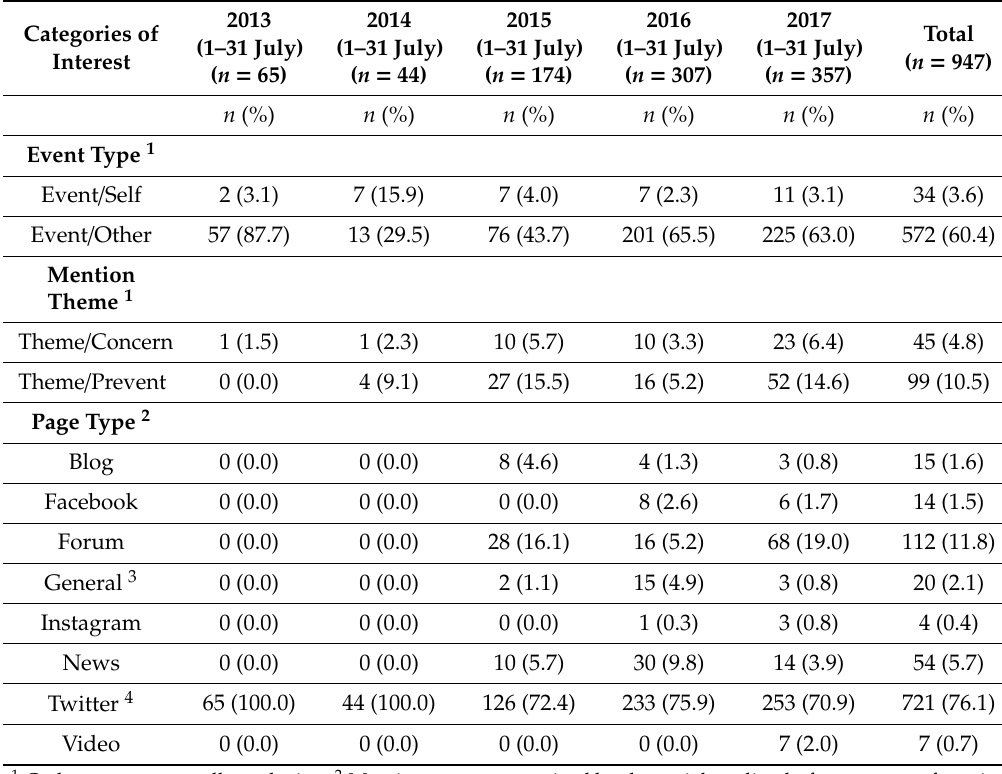
Table 1. Summary of relevant social media mentions collected in the electronic nicotine delivery systems (ENDS) overheating, fires, and explosions (O / F / E) query, by event type, mention theme, and page type,